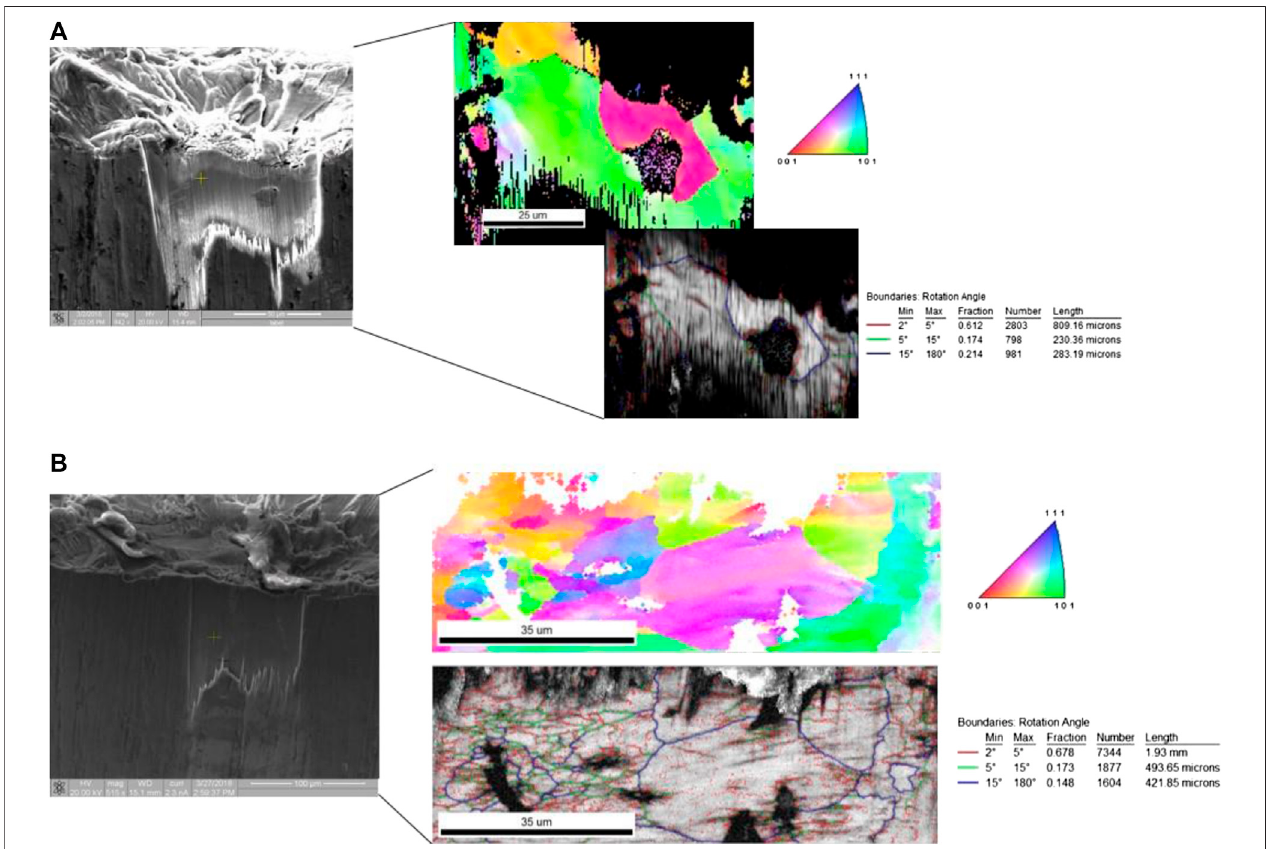
FIGURE 7 | EBSD scans at the initiation site of the (A) LCF t/2 and (B) LCF t/4 specimens. Both sites were FIBed such that a smooth 50-100 μ m wide surface remained for EBSD analysis.